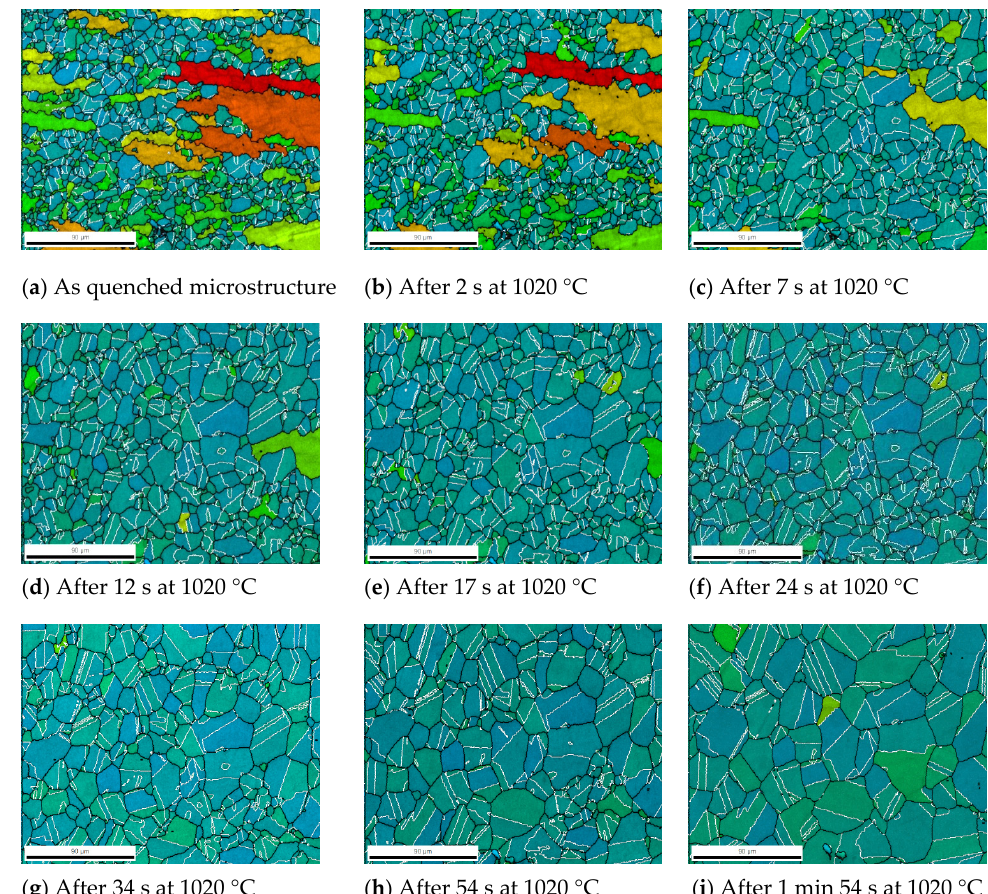
Figure 6. Microstructure evolution of sample C (initial DRX volume fraction = 65%) after successive post ‐ dynamic annealing steps at 1020 °C (cumulated holding times are indicated below each micrograph). Intragranular misorientation GOS maps superimposed with the Pattern Quality map. Scale bar: 90 μ m. Grain boundaries (>15°) in black and twin boundaries (60° <111>) in white. GOS color ‐ coding from 0 to 10.5°: .